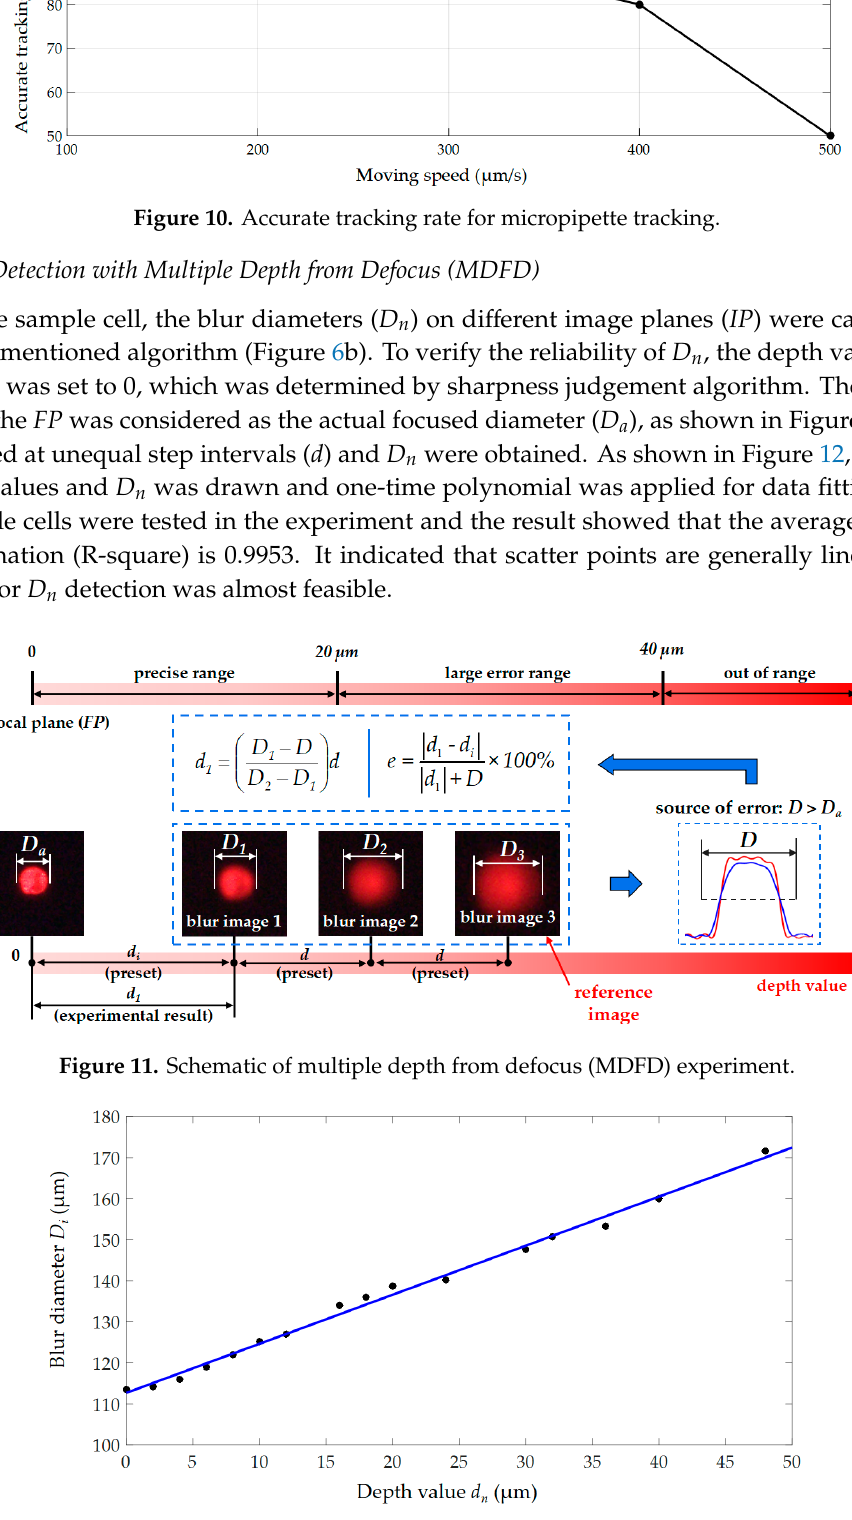
Figure 12. Linear distribution of d n and D n for 1 out of 10 samples.